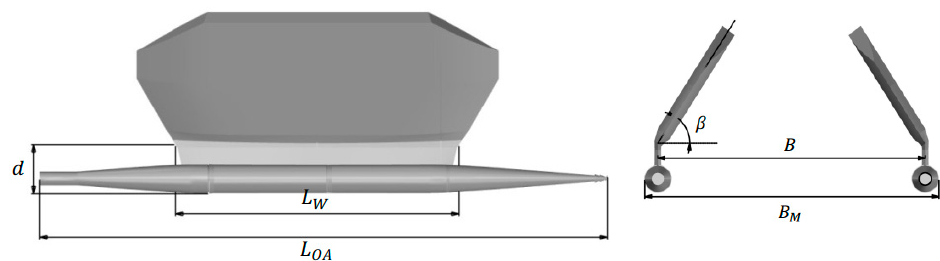
Figure 2. Geometry model of the SWATH.